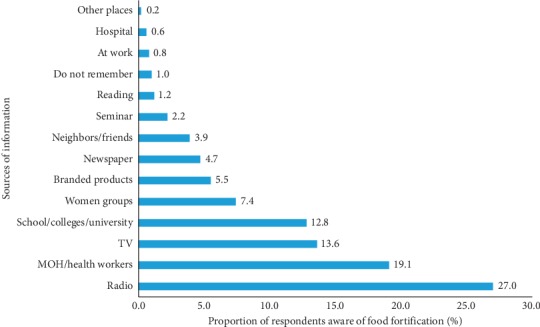
Sources of food fortification information.